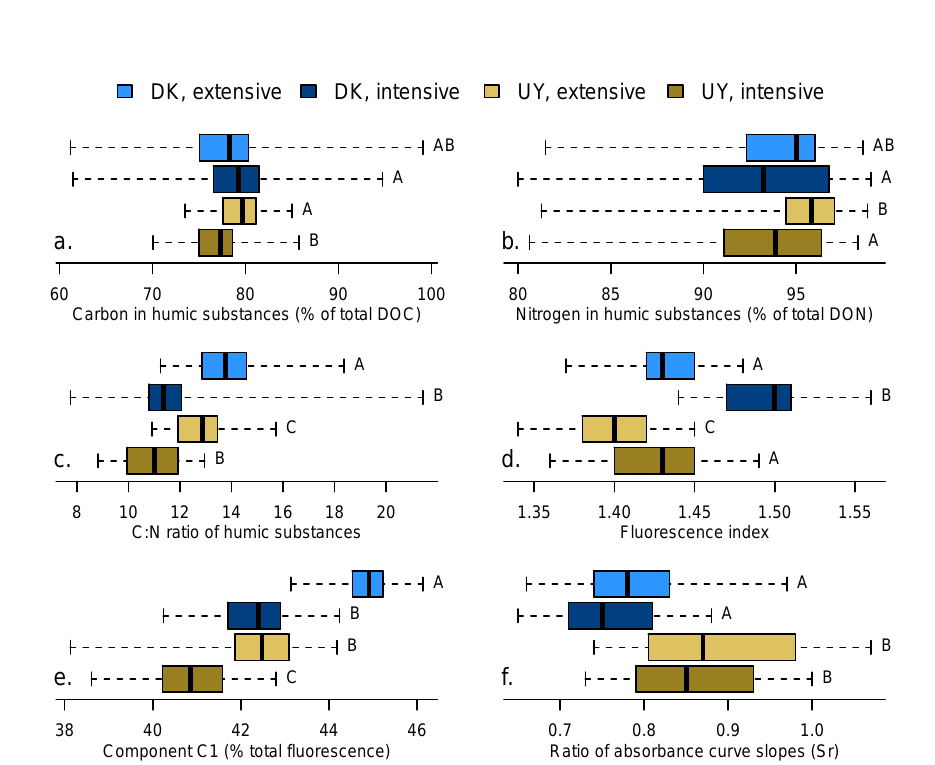
Figure 4. Selected variables of dissolved organic matter composition (DOM). Capital letters indicate significantly different groups ( p < 0.05, Nemenyi pairwise test, n was 47–49, depending on the stream). DK, Denmark; UY, Uruguay; extensive, extensive farming; intensive, inten- sive